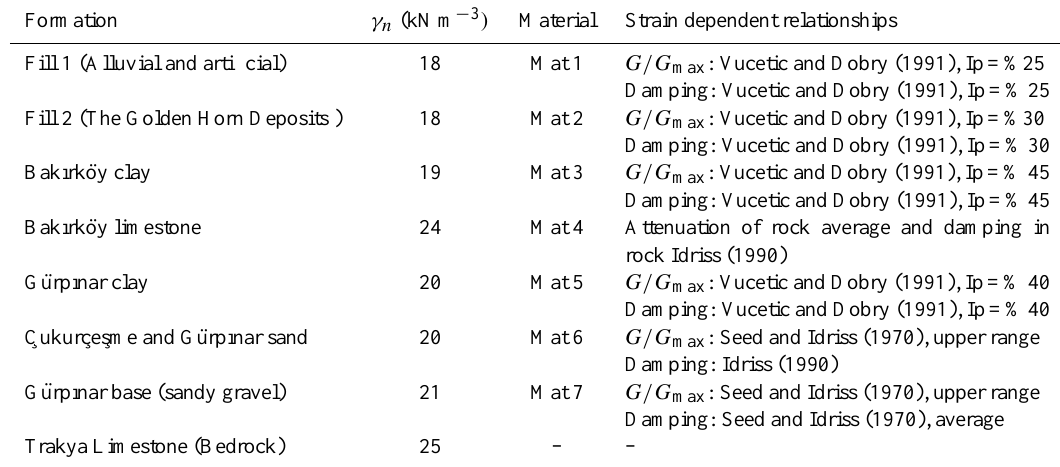
Table 2. Strain dependent relationships used in the site response analysis. Formation γ n (kNm − 3 ) Material Strain dependent relationships Fill 1 (Alluvial and artificial) 18 Mat 1 G/G max : Vucetic and Dobry (1991), Ip=%25 Damping: Vucetic and Dobry (1991), Ip=%25 Fill 2 (The Golden Horn Deposits )